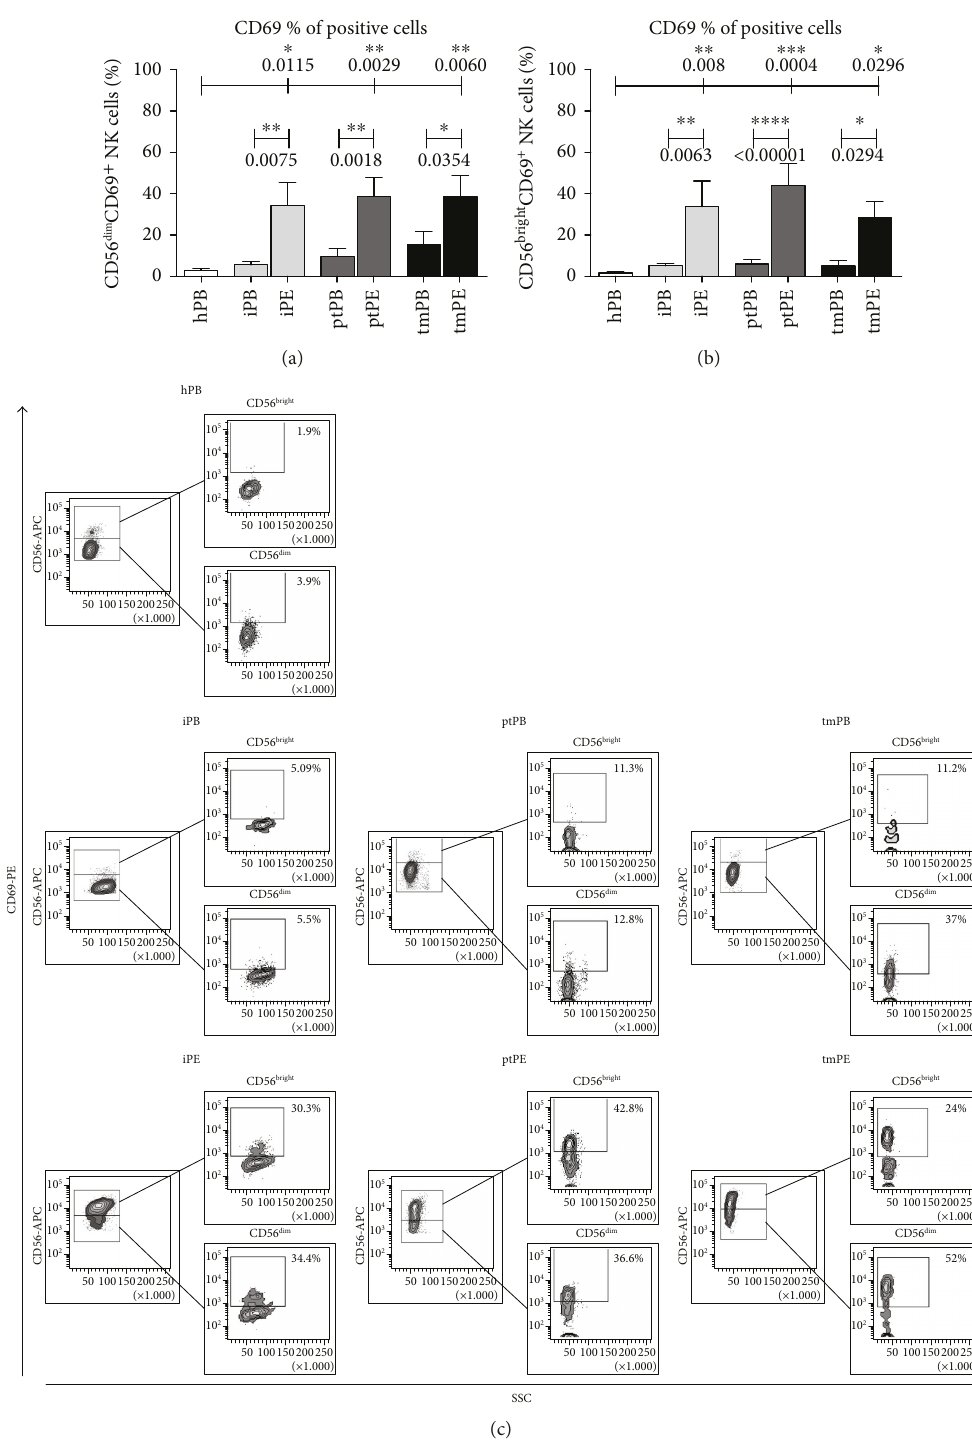
Figure 4: CD69 expression on NK cell subsets. Flow cytometric analysis on NK cell subsets of healthy individuals (hPB), peripheral blood (iPB) and pleural e ff usion (iPE) from patients with in fl ammatory disease, peripheral blood (ptPB) and pleural e ff usion (ptPE) from patients with primary tumor, and peripheral blood (tmPB) and pleural e ff usion (tmPE) from patients with tumor metastasis revealed upregulation of CD69, an activating and decidual NK marker, in PE samples compared to autologous and healthy control PB-NK cells (a, b). CD69 increased expression was statistically signi fi cant in both CD56 bright and CD56 dim NK cell subsets with higher percentage in CD56 bright . Representative dot plots of CD69 (c) distribution in CD56 bright and CD56 dim NK cell subsets in healthy donors and patients with in fl ammatory, primary, and metastatic tumor PE are shown, respectively. Data are shown as mean ± SEM of 39 samples; ∗ p < 0 05 , ∗∗ p < 0 01 , ∗∗∗ p < 0 001 , and ∗∗∗∗ p < 0 0001 ( p values are